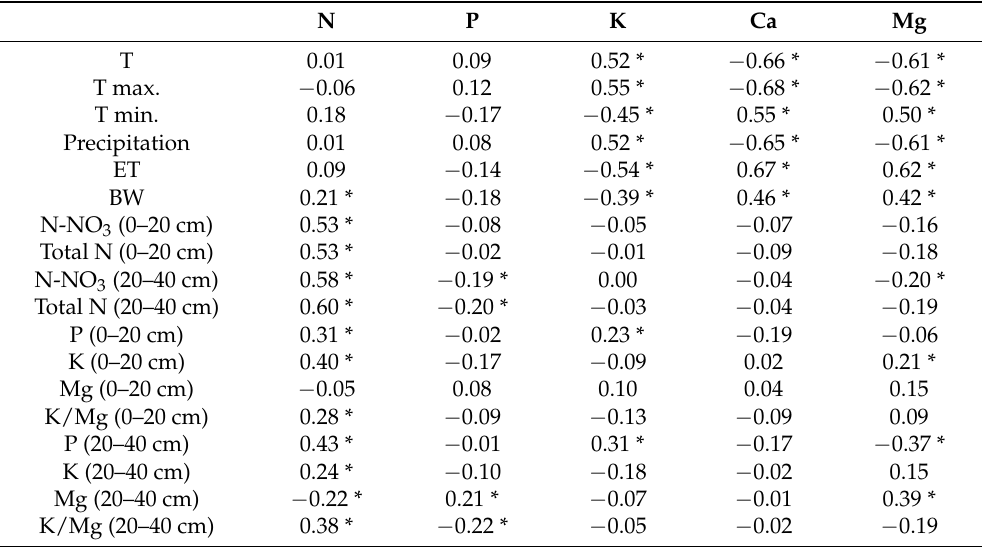
Table 7. Influence of climatic conditions and soil mineral content on leaf